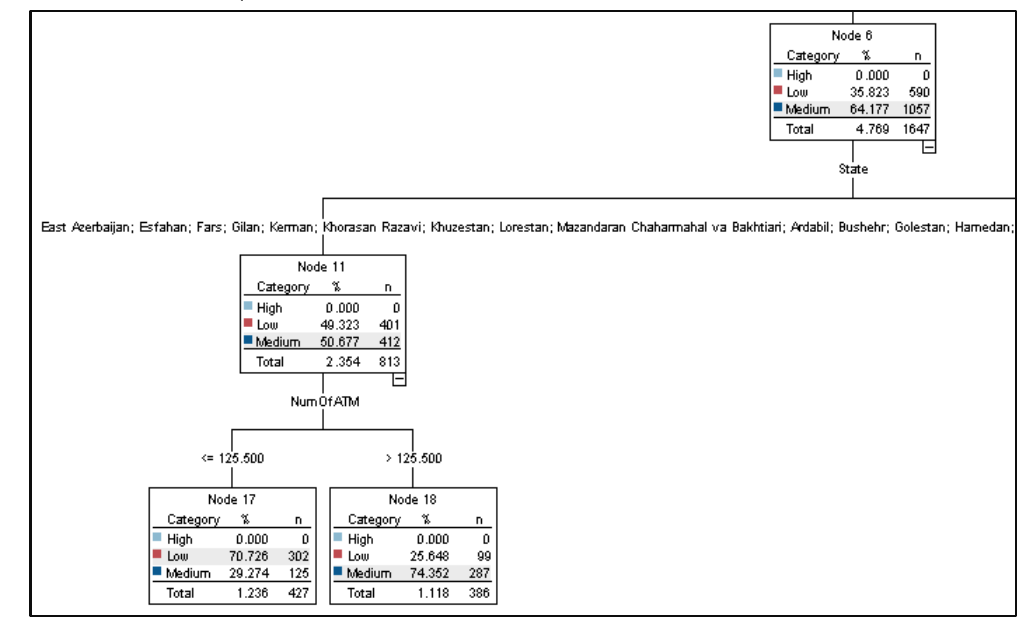
Figure 10. Branches of Rules 16 and